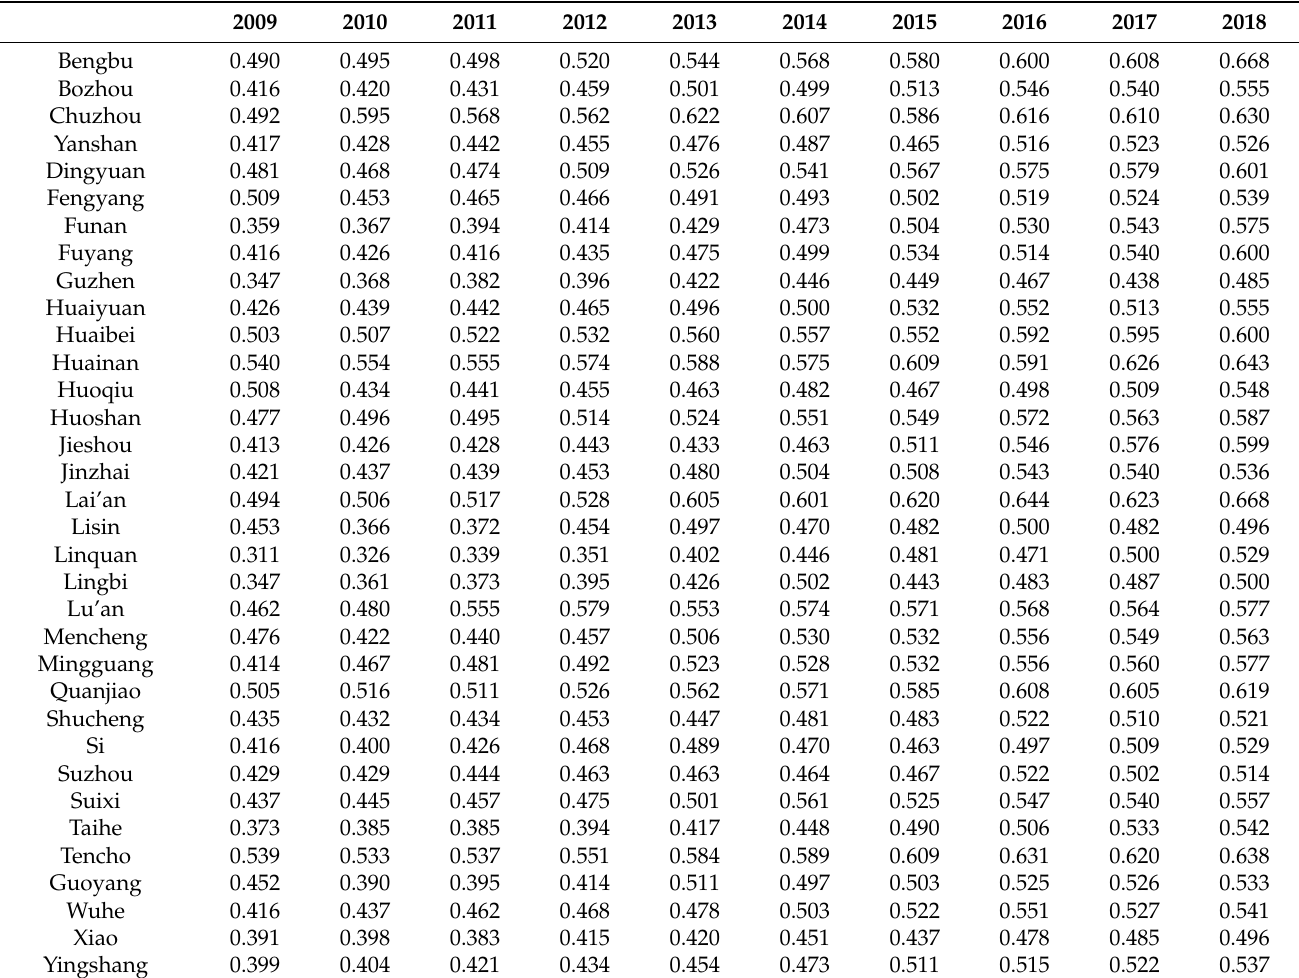
Table 3. Results of coupling coordination degree by